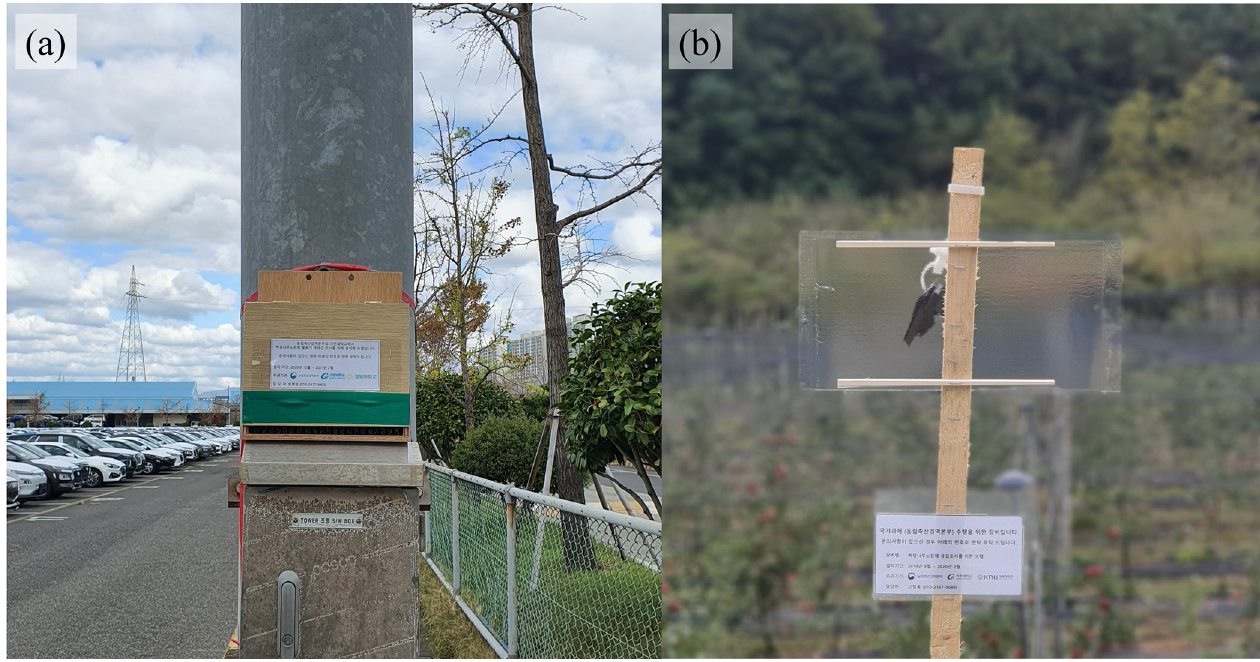
Fig 1. Representative photos of (a) overwintering shelter and (b) clear sticky pheromone trap, to detect overwintering and active Halyomorpha halys ,